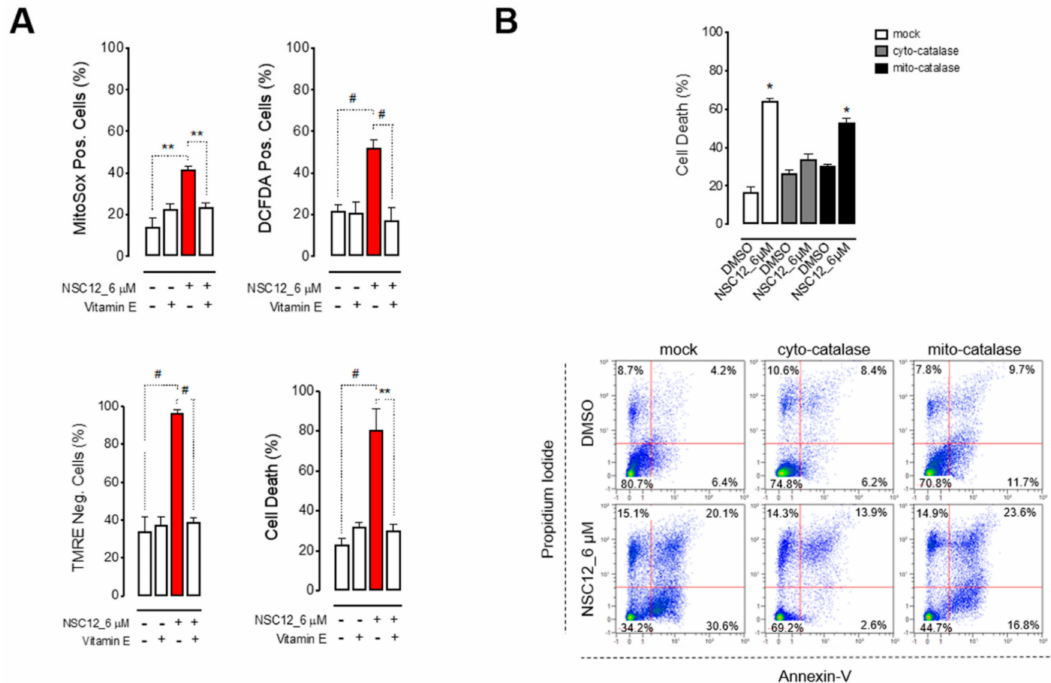
Figure 4. FGF trapping induces oxidative-stress-mediated apoptosis in FGF-dependent lung cancer cells. ( A ) H520 cells were treated with NSC12 in presence or absence of vitamin E (220 µ M) for 48 h and cytofluorimetric analyses for mitochondrial or cytoplasmic ROS production, mitochondrial membrane depolarization and apoptosis by Mitosox, DCF-DA, TMRE and propidium iodide / Annexin-V stainings, respectively, were performed. ( B ) Upper panel: Percentage of mock and mitochondrial or cytoplasmic catalase-overexpressing H520 cell death (calculated as the sum of Annexin-V +/ PI − , Annexin-V +/ PI + , Annexin-V − / PI + ) after treatment with NSC12 for 48 h. Lower panel: representative dot plots from citofluorimetric analysis. Data are mean ± SEM of 3 or more experimental replicates. * p < 0.05, ** p < 0.01, # p <